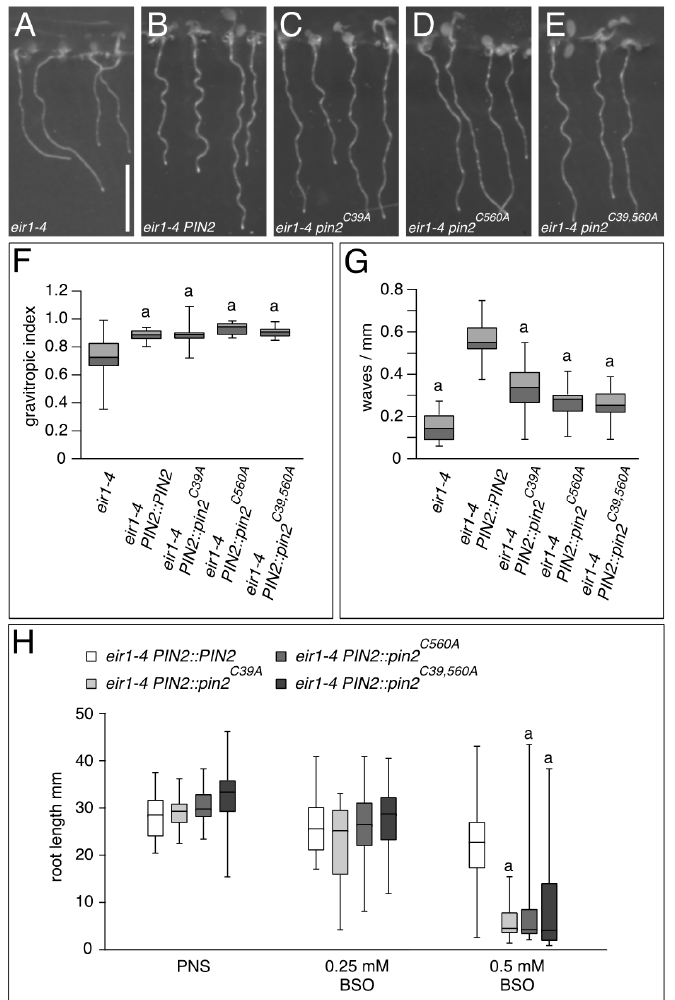
Figure 5. Growth of pin2 C − A alleles. ( A – E ) Comparison of: eir1-4 ( A ); eir1-4 PIN2::PIN2 ( B ); eir1-4 PIN2::pin2 C39A ( C ); eir1-4 PIN2::pin2 C560A ( D ); and eir1-4 PIN2::pin2 C39,560A seedlings at 6 DAG. Size bar corresponds to 10 mm; ( F ) Box plot displaying the root gravitropic index of eir1-4 , eir1-4 PIN2::PIN2 , eir1-4 PIN2::pin2 C39A , eir1-4 PIN2::pin2 C560A , and eir1-4 PIN2::pin2 C39,560A , according to Grabov and colleagues [32] at 6 DAG. In total, 13–27 roots were tested for each genotype. “a” indicates a significant difference to eir1-4 ( p < 0.01), determined by One-way ANOVA with post-hoc Tukey HSD test. No significant differences were observed when comparing eir1-4 PIN2::PIN2 to eir1-4 PIN2::pin2 C39A , eir1-4 PIN2::pin2 C560A , and eir1-4 PIN2::pin2 C39,560A . Whiskers represent the entire range of outliers obtained in the datasets; dark grey and light grey boxes display first and third quartiles, respectively. ( G ) Box plot, displaying the root waviness of eir1-4, eir1-4 PIN2::PIN2 , eir1-4 PIN2::pin2 C39A , eir1-4 PIN2::pin2 C560A , and eir1-4 PIN2::pin2 C39,560A at 6 DAG, grown on vertically orientated agar (1.5% ( w / v )) nutrient plates. In total, 21–27 roots were tested for each genotype. “a” indicates a significant difference to eir1-4 PIN2::PIN2 ( p < 0.01), determined by One-way ANOVA with post-hoc Tukey HSD test. Whiskers represent the entire range of outliers obtained in the datasets; dark grey and light grey boxes display first and third quartiles, respectively; ( H ) Box plot displaying the primary root length of eir1-4 PIN2::PIN2 , eir1-4 PIN2::pin2 C39A , eir1-4 PIN2::pin2 C560A , and eir1-4 PIN2::pin2 C39,560A at 7 DAG, when germinated in presence of indicated concentrations of buthionine sulphoximine (BSO). In total, 20–32 seedlings were analyzed for each genotype “a” indicates a significant difference to eir1-4 PIN2::PIN2 ( p < 0.01), determined by One-way ANOVA with post-hoc Tukey HSD test. Whiskers represent the entire range of outliers obtained in the